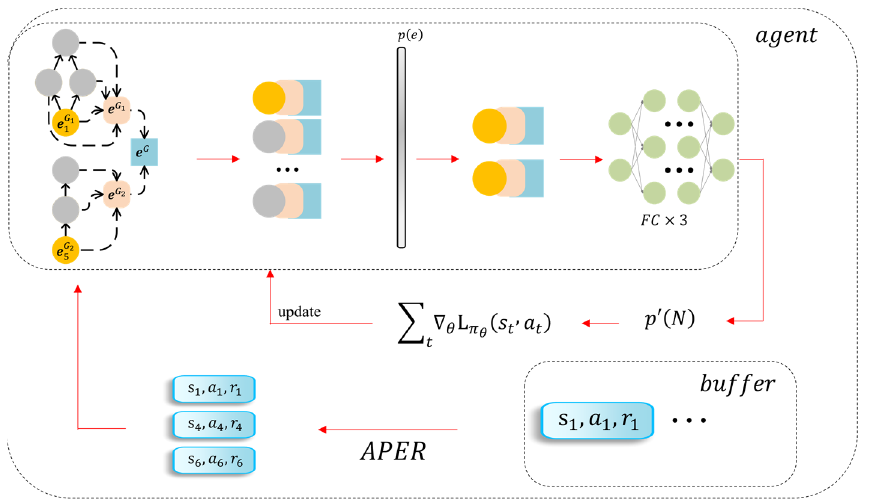
Figure 5. Training process.